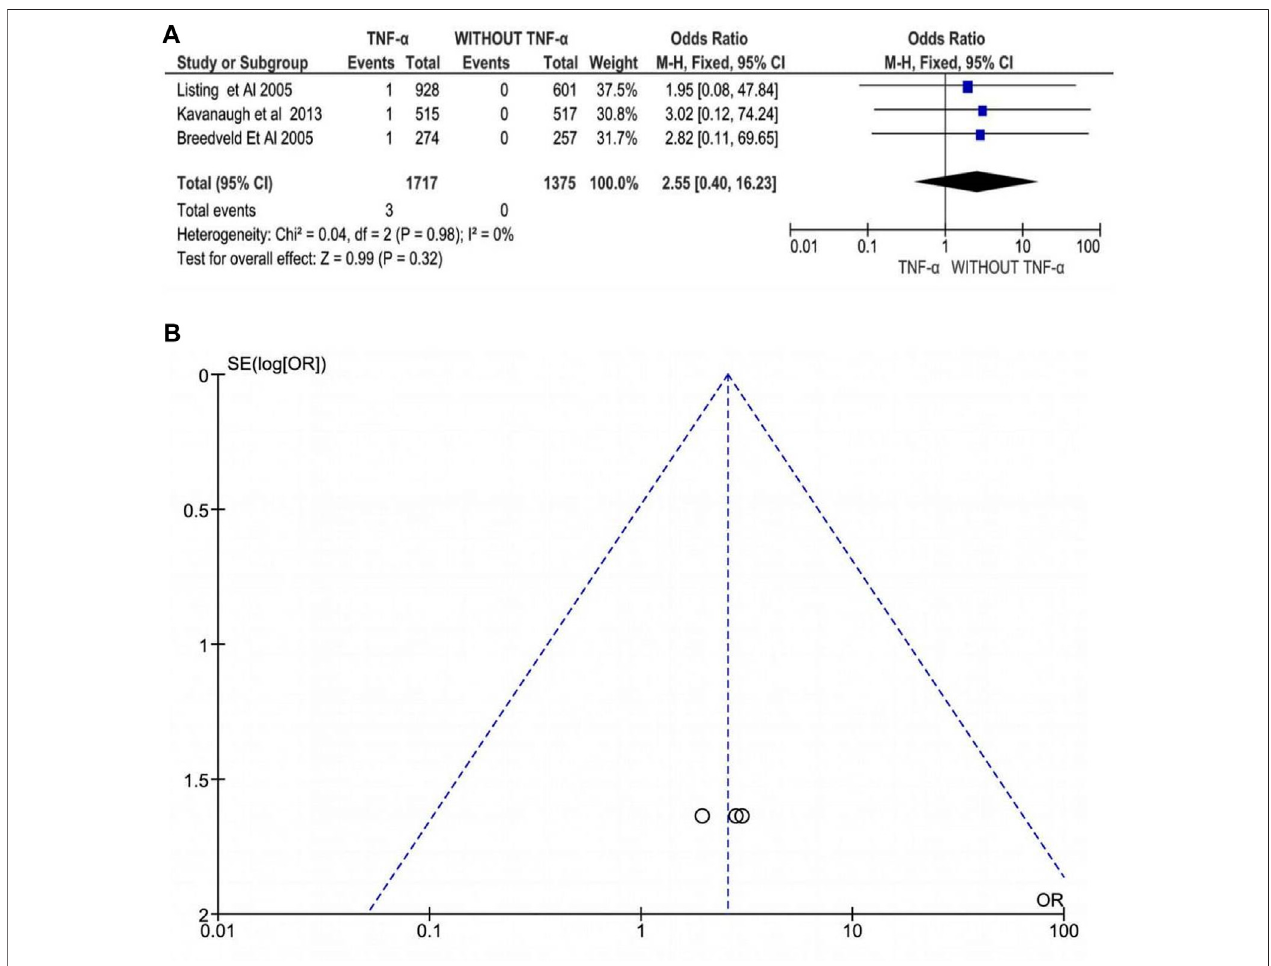
FIGURE4 |(A) Forest plotfor tuberculosis infection after treatment withanti-TNF α agentsversuscontrol group (withoutanti-TNF α agents) using arandom-effects model. Odds ratios and 95% con fi dence intervals are shown (B) Funnel plot for assessment of publication bias.